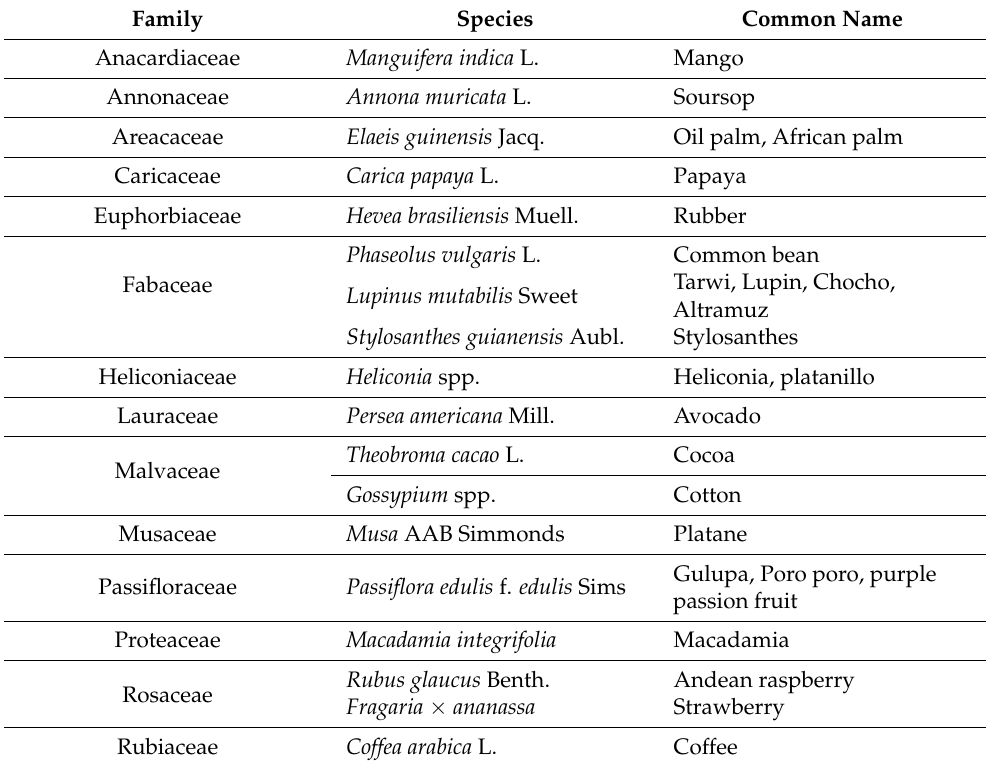
Table 2. Families and botanical species in Colombia, Ecuador, Peru, and Venezuela reported to have diseases caused by Colletotrichum species